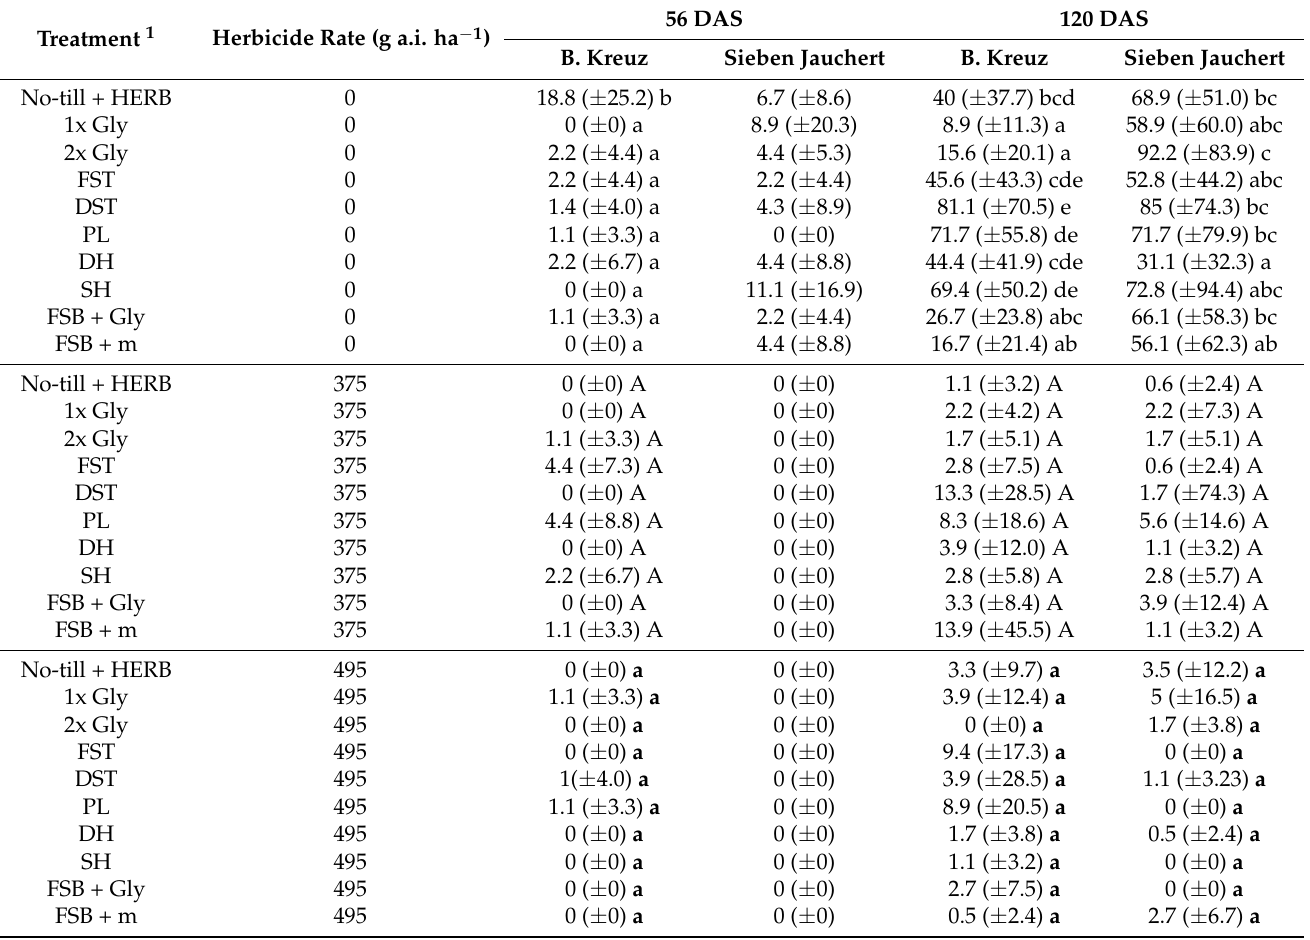
Table 6. A. myosuroides density (plants m − 2 ) 56 DAS and 120 DAS at B. Kreuz and Sieben Jauchert. Levels of significance are shown behind the result for each experimental site and date separately. Means with different small letters show significant differences within the herbicide rate of 0 g a.i. ha − 1 according to Tukey’s HSD test at α ≤ 0.05. Means with different capital letters show significant differences within the herbicide rate of 375 g a.i. ha − 1 according to Tukey’s HSD test at α ≤ 0.05. Means with different bold small letters show significant differences within the herbicide rate of 495 g a.i. ha − 1 according to Tukey’s HSD test at α ≤